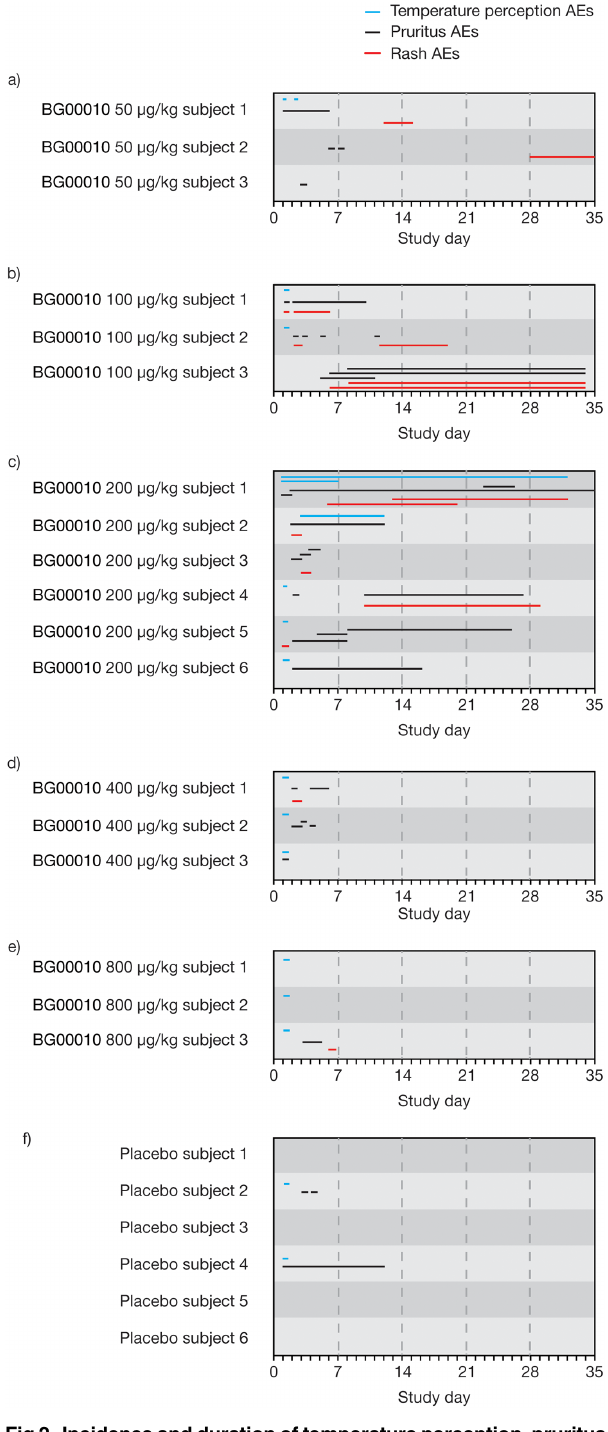
Fig 2. Incidence and duration of temperature perception, pruritus and rash AEs. Subjects were treated as follows: intravenous BG00010 (a) 50 μ g/kg, (b) 100 μ g/kg, (c) 200 μ g/kg, (d) 400 μ g/kg, (e) 800 μ g/kg, or (f) placebo. AE, adverse